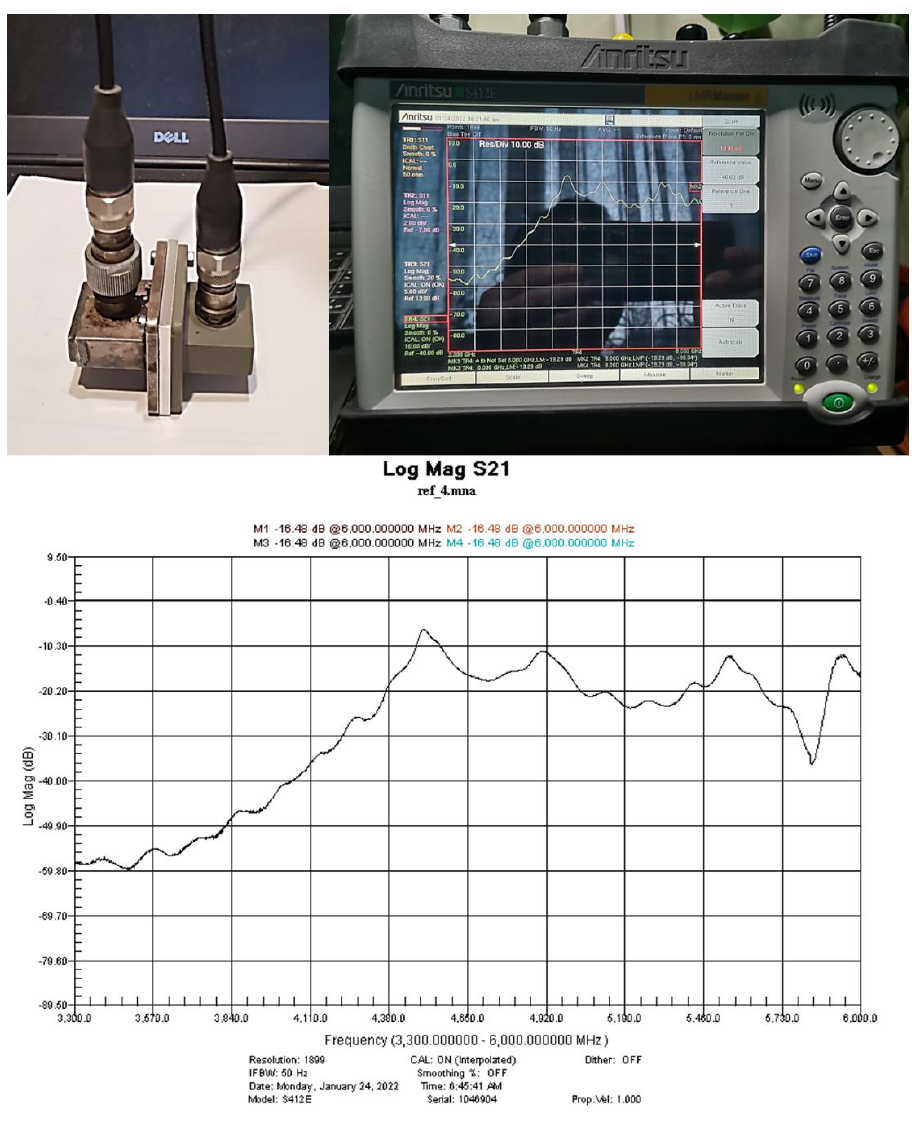
Figure 1. The measuring setup for EMI-shielding efficiency based on the ANRITSU Vector-Network Analyzer.